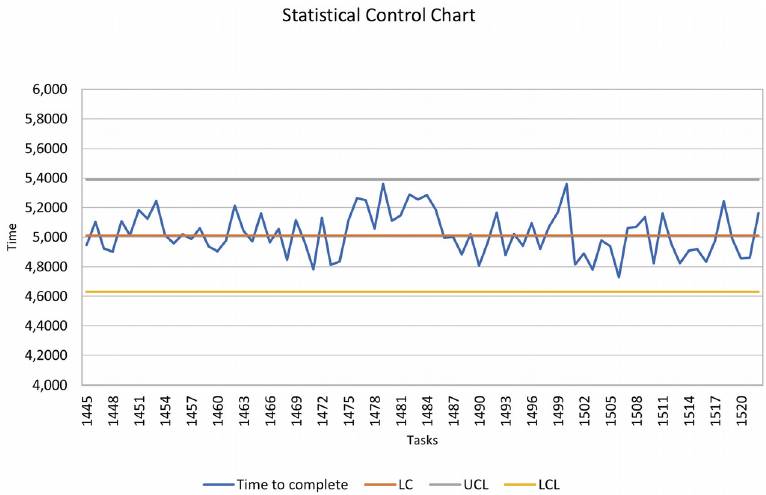
Figure 2. I-chart example for learning objects